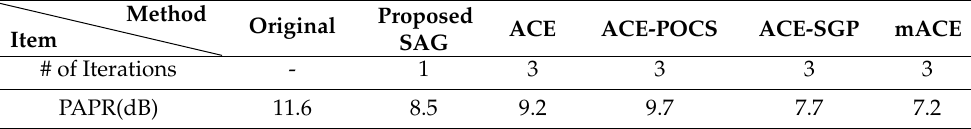
Table 2. PAPR performance comparison for QPSK–OFDM with N = 256.